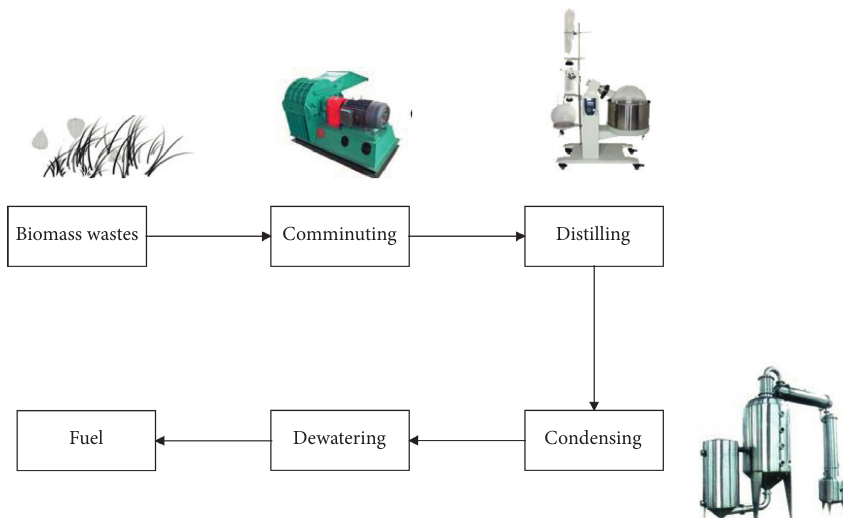
Figure 6: Schematic process of the ethanol fermentation